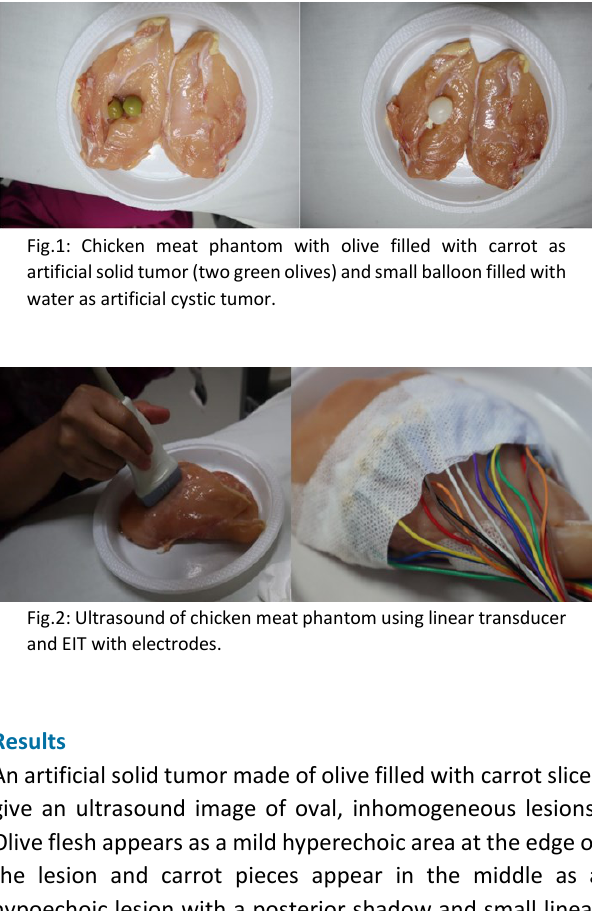
Fig.5: GREIT method with 32 electrodes of artificial solid tumor shows a match between the reconstructed image and the original object containing two anomalies.